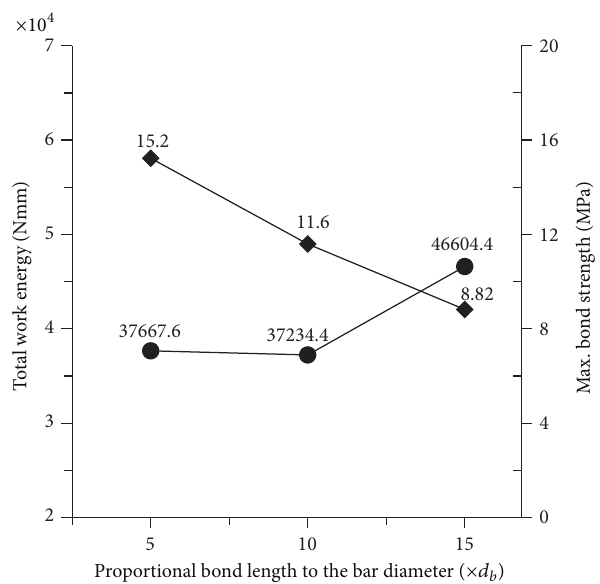
Figure5:Totalworkenergyandmaximumbondstrengthaccording to the embedded bond length.